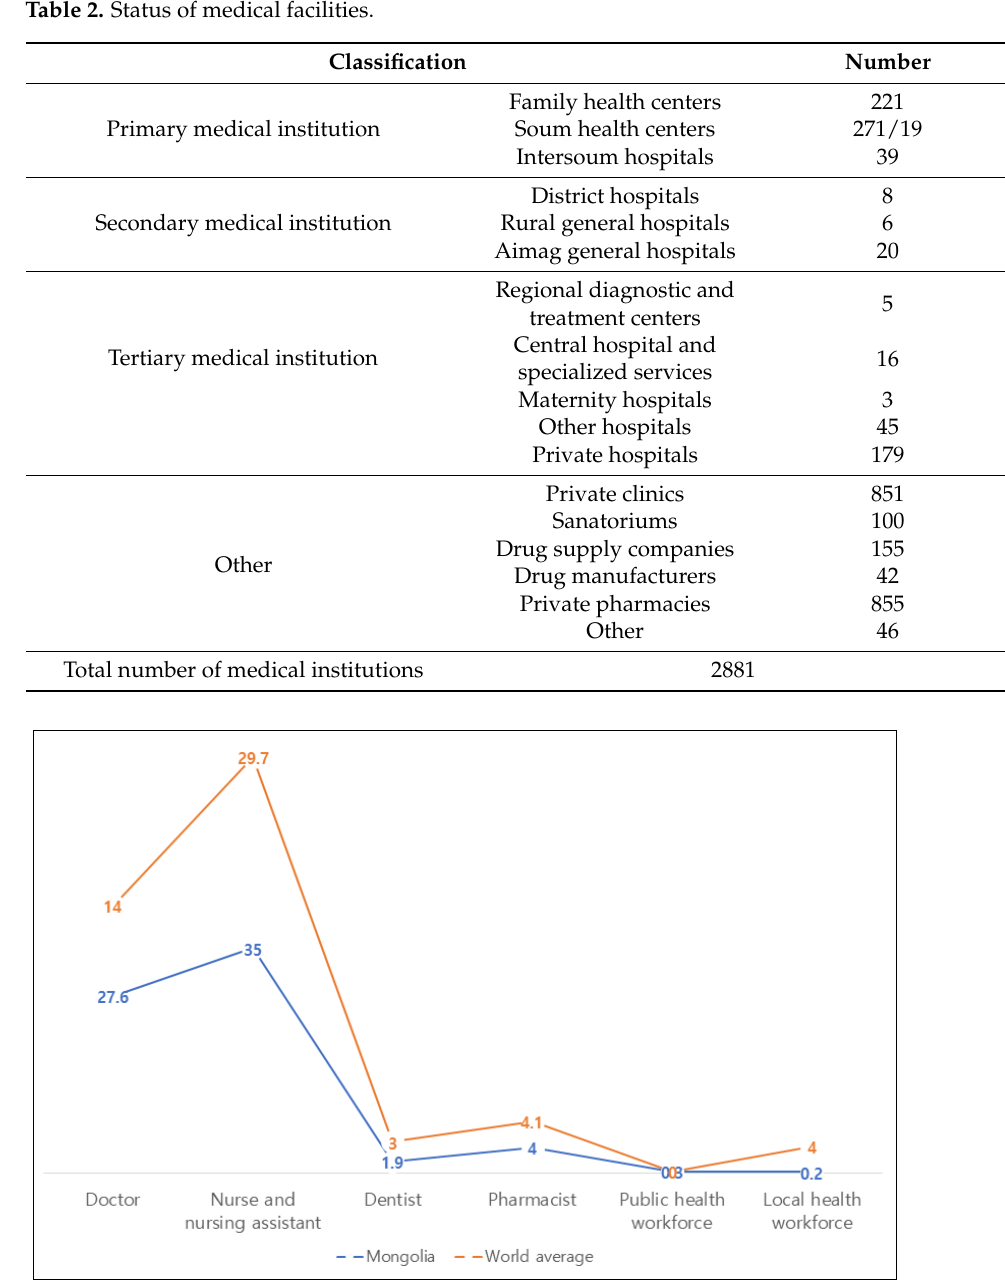
Figure 6. Comparison of medical professionals in Mongolia and the world.